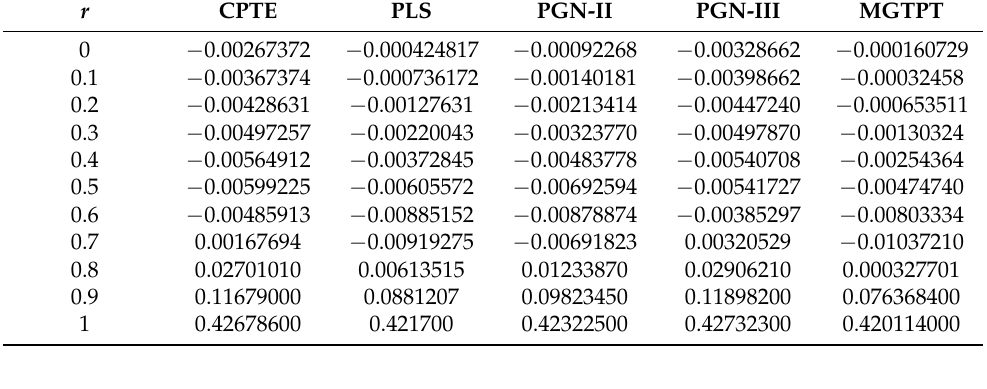
Table 6. The Maxwell’s stress τ rr under different photothermal models.